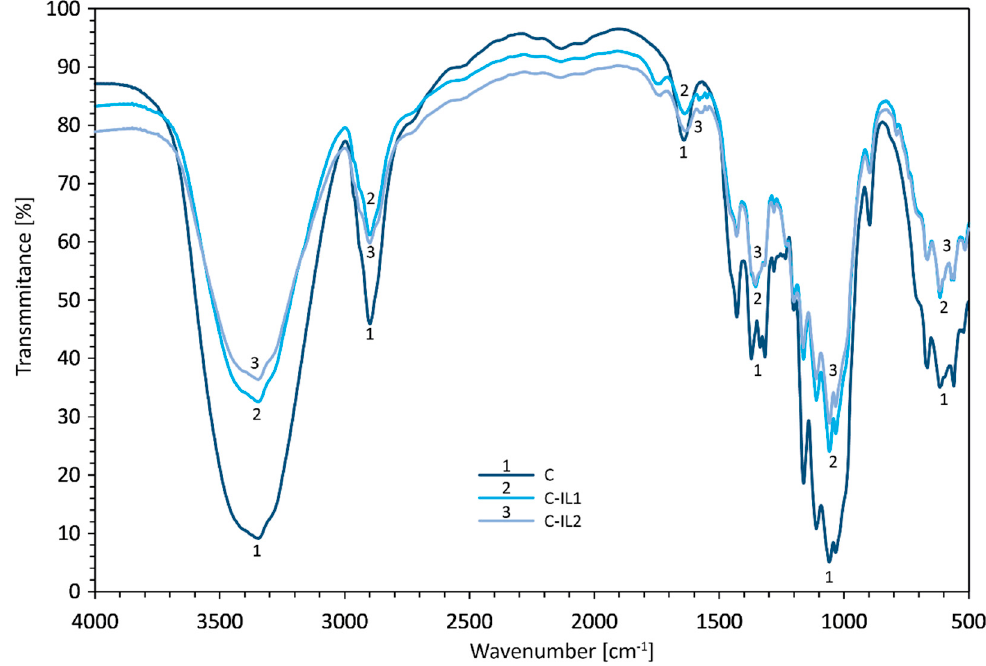
Figure 2. FTIR spectra for cellulose nanofiller before the chemical modification reaction (C) and after treatment with imidazolium ionic liquids with a shorter alkyl linker (C-IL1) and a longer linker (C- IL2).